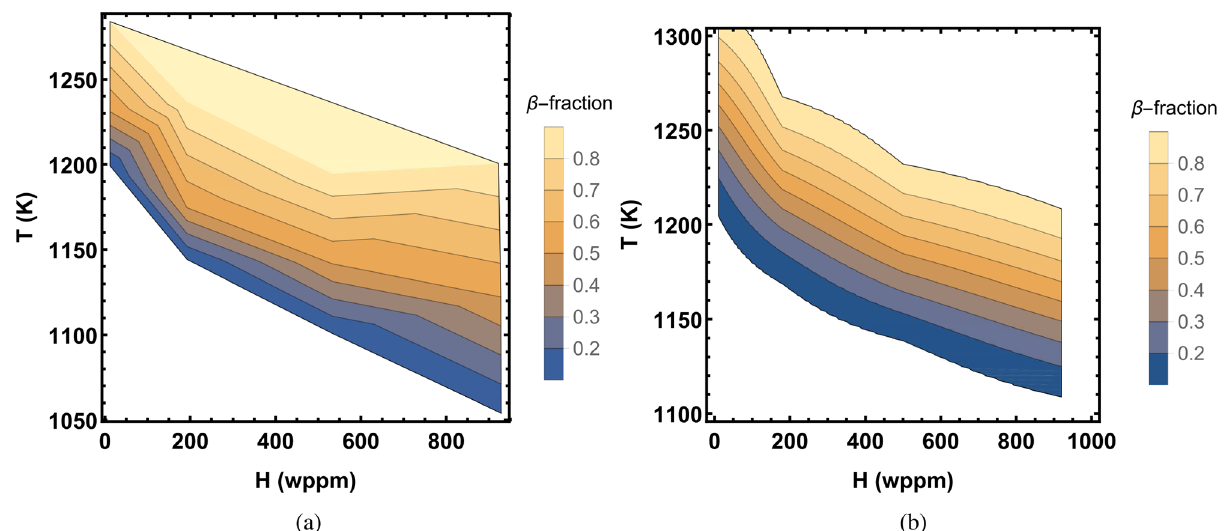
Figure 10. Contour plots of α/β phase transformation temperatures in Zircaloy-4 as a function of